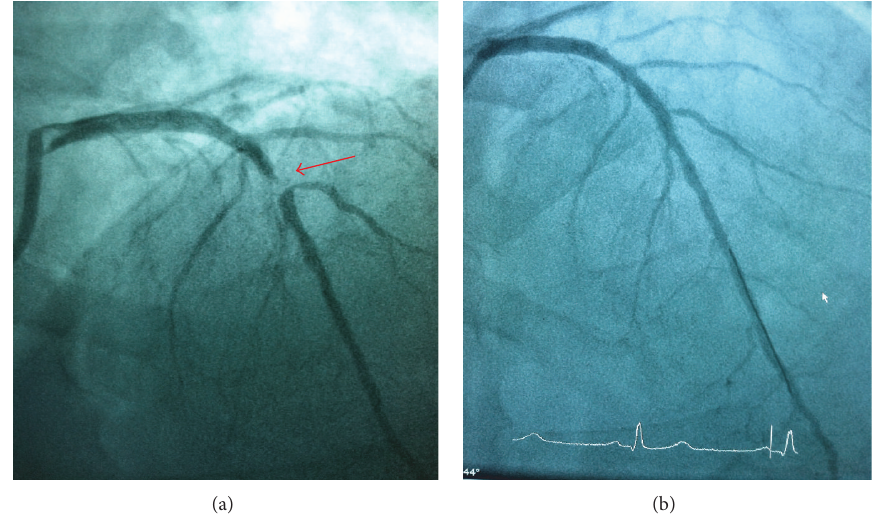
Figure 4: Coronary angiography. (a) Mid-LAD lesion (red arrow) and no proximal LAD abnormality: (b) after placement of